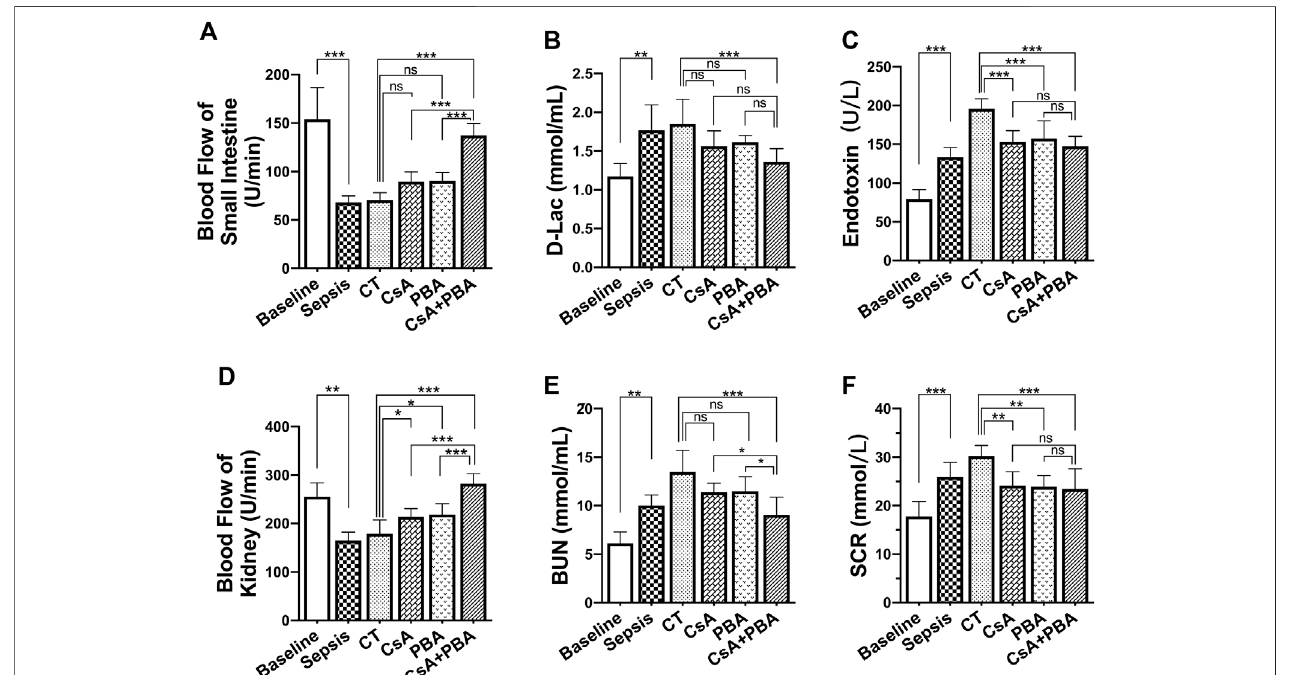
FIGURE2| Synergeticeffect ofPBAand CsAonimprovingtissue perfusion andorganfunctioninCLP-inducedsepticshockrats.( n (cid:1) 8/group) (A) ,theblood fl ow ofintestine; (B-C) ,intestinalbarrierinjuryindices( D -lactateand endotoxin); (D) ,theblood fl owofkidney; (E-F) ,renalfunction(bloodureanitrogen and serum creatinine). CsA, cyclosporine A; PBA, 4-phenylbutyrate acid; CT, conventional treatment. * p < 0.05, ** p < 0.01, *** p < 0.001.